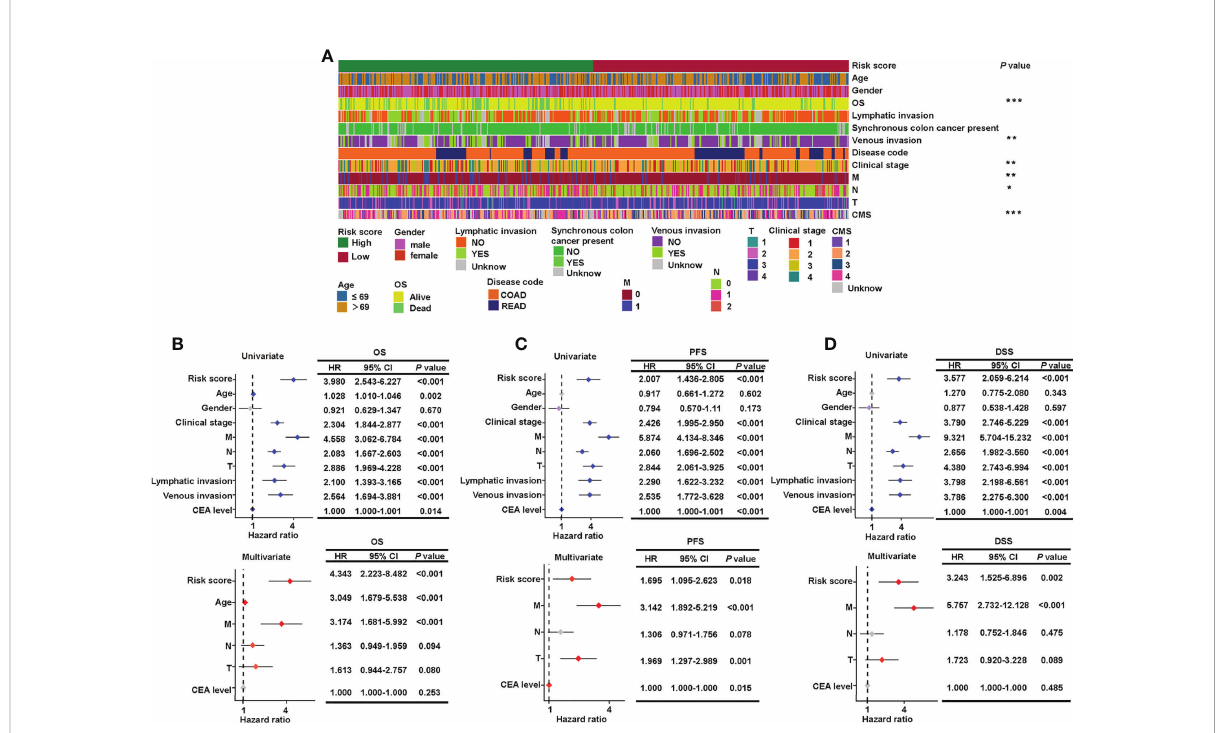
FIGURE 4 Veri fi cation of the relationship between risk score and clinicopathological features. (A) Clinical details of 543 patients and the signi fi cant difference between high- and low-risk groups. Forest plots of the hazard ratios predicting OS (B) , PFS (C) , and DSS (D) in univariate and multivariate Cox regression models. OS, overall survival; DSS, disease-speci fi c survival; and PFS, progression-free survival. *** P < 0.001; ** P < 0.01; * P<